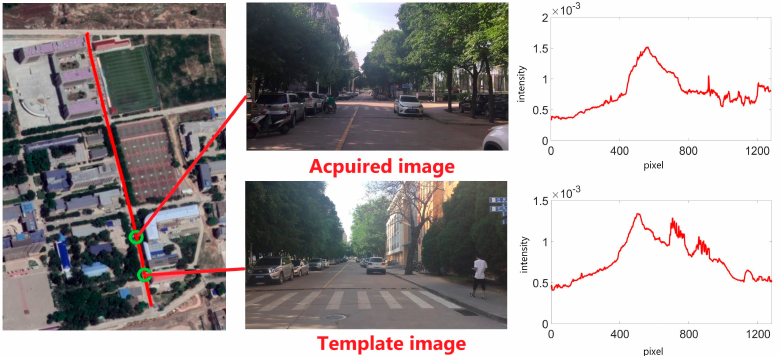
Figure 14. The specific locations on the map, raw images and their scanline profiles where the misjudgment happened. (The value of β ’ of these two images is 0.0743.). Therefore, the SI algorithm, which is only based on the scanline intensity profile, is considered not reliable, and would cause serious consequences in the actual application if misjudgment occurs.